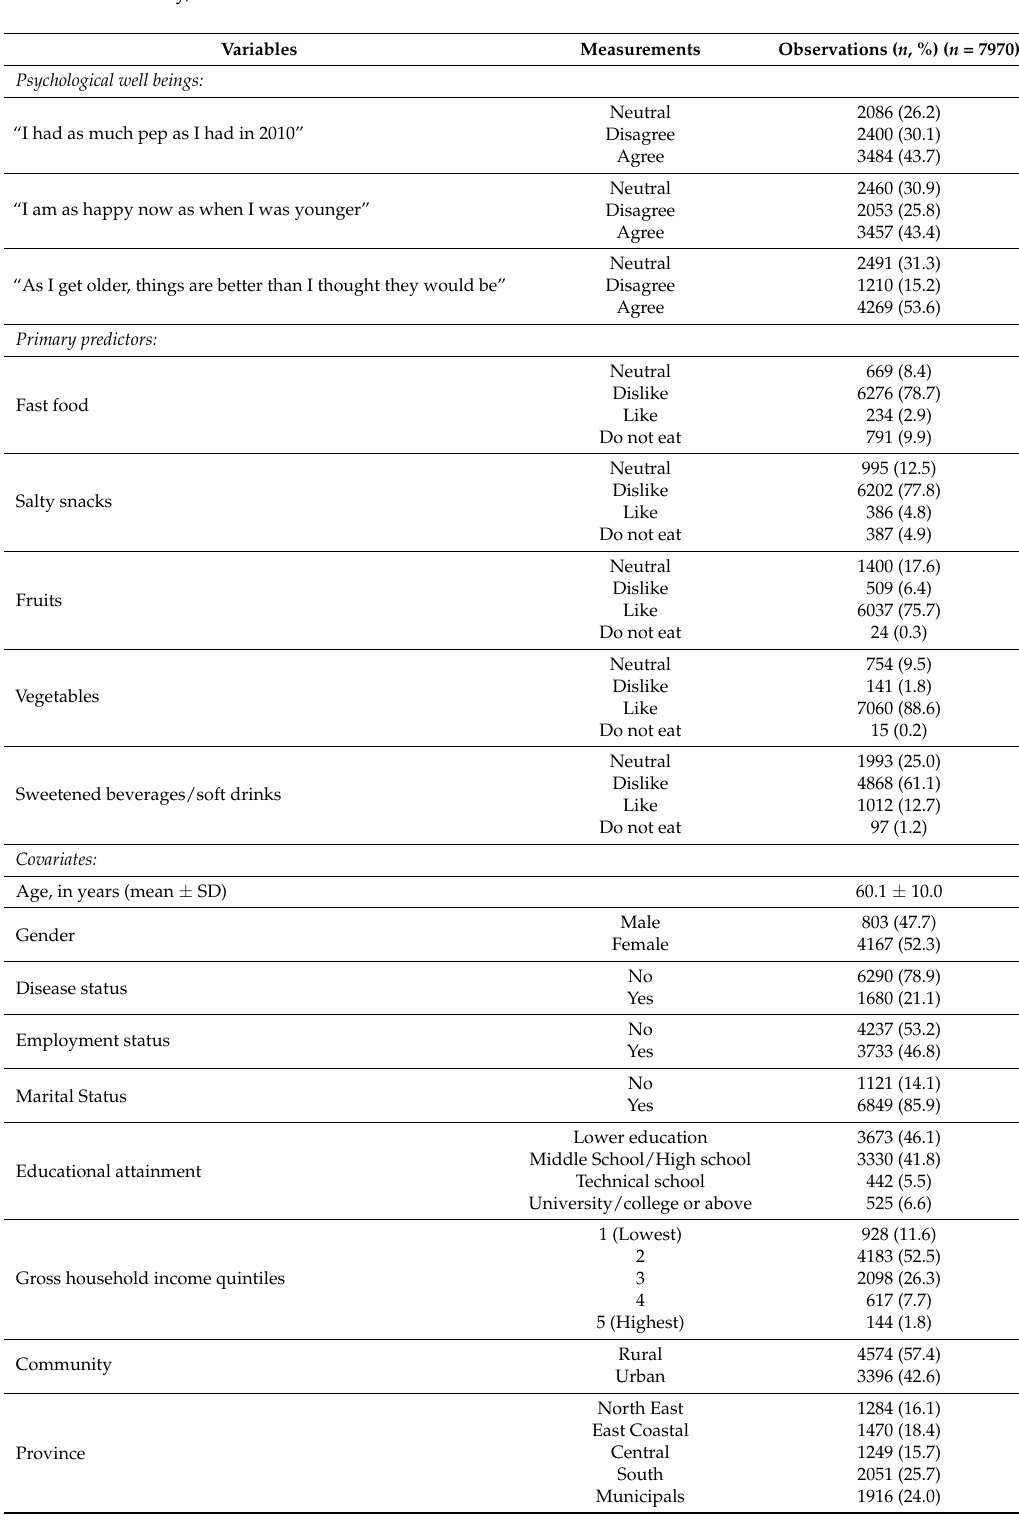
Table 1. Frequency distributions for the final study sample ( n = 7970). Data: China Health and Nutrition Survey,